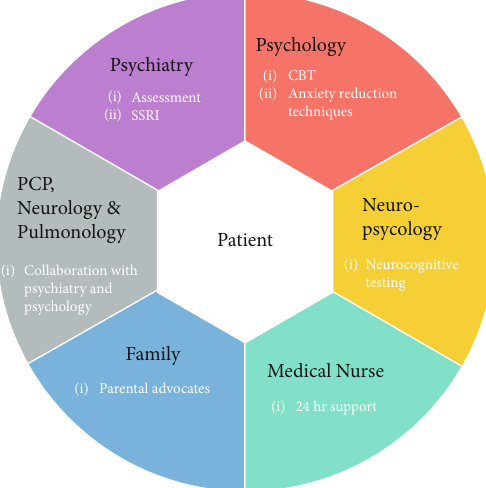
Figure 1: Collaborative care model of treatment for patient with CCHS and speci fi c